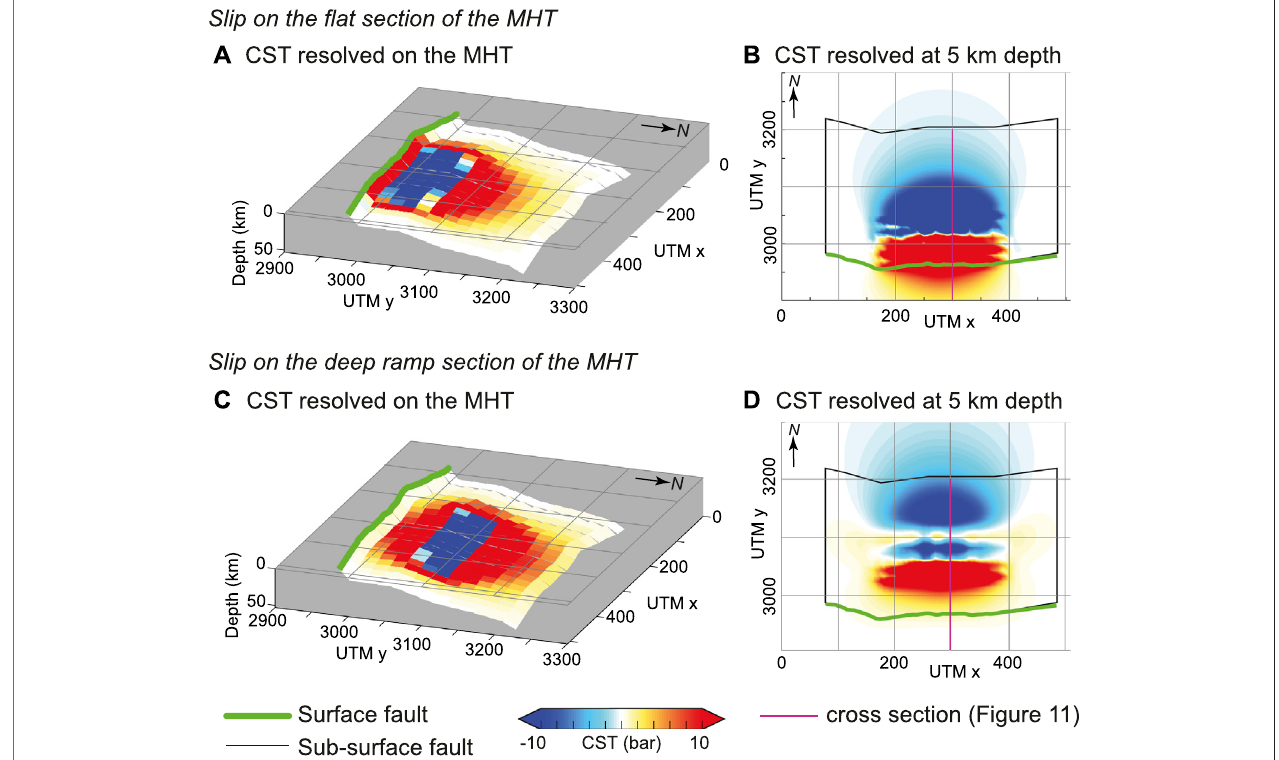
FIGURE10| ModelsofCoulombStressTransfer(CST)forrepresentativeearthquakes.ThecolorscaleofCSTisthesameforall fi gures. (A) .sliponthe fl atsection oftheMHTwithstressresolvedontotherestoftheMHT, (B) .sliponthe fl at sectionwithstressresolved at5 kmdepthontoreceiverfaultswiththegeometry 270/45/90 (strike/dip/rake), (C) . slip on the deep ramp ( > 15 km depth) of the MHT with stress resolved onto the rest of the MHT, (D) . slip on the deep ramp with stress resolved at 5 km depth onto receiver faults with the geometry 270/45/90.